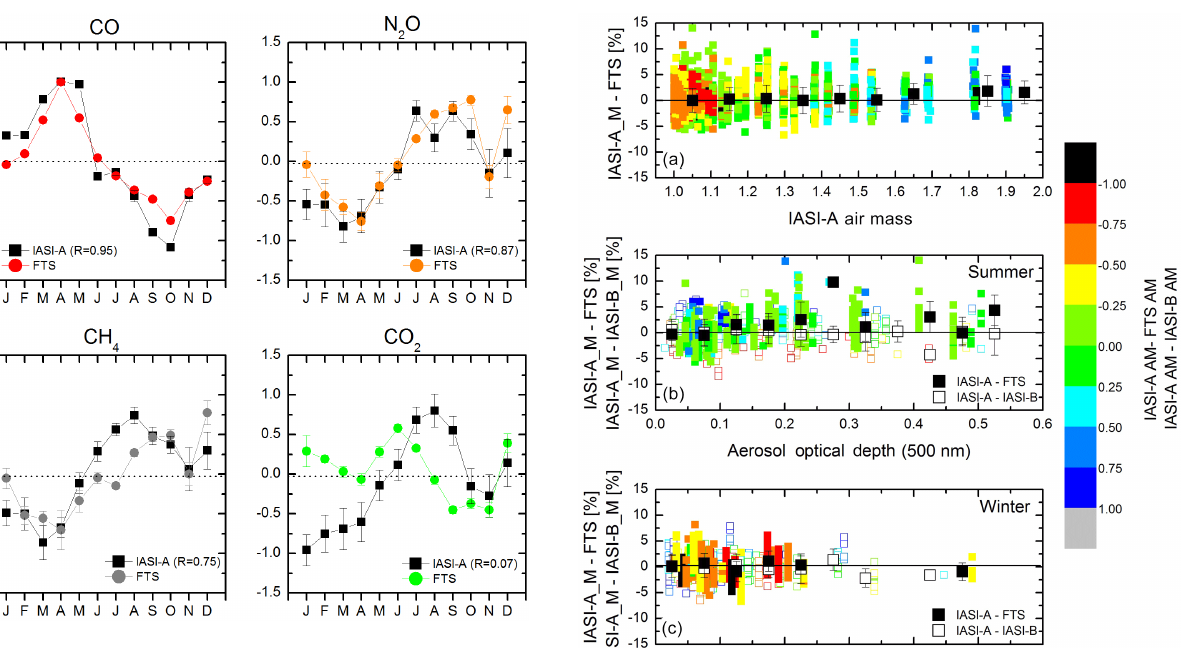
Figure 8. Multi-annual averaged annual cycle for CO, N 2 O, CH 4 , and CO 2 from IASI-A and FTS observations.